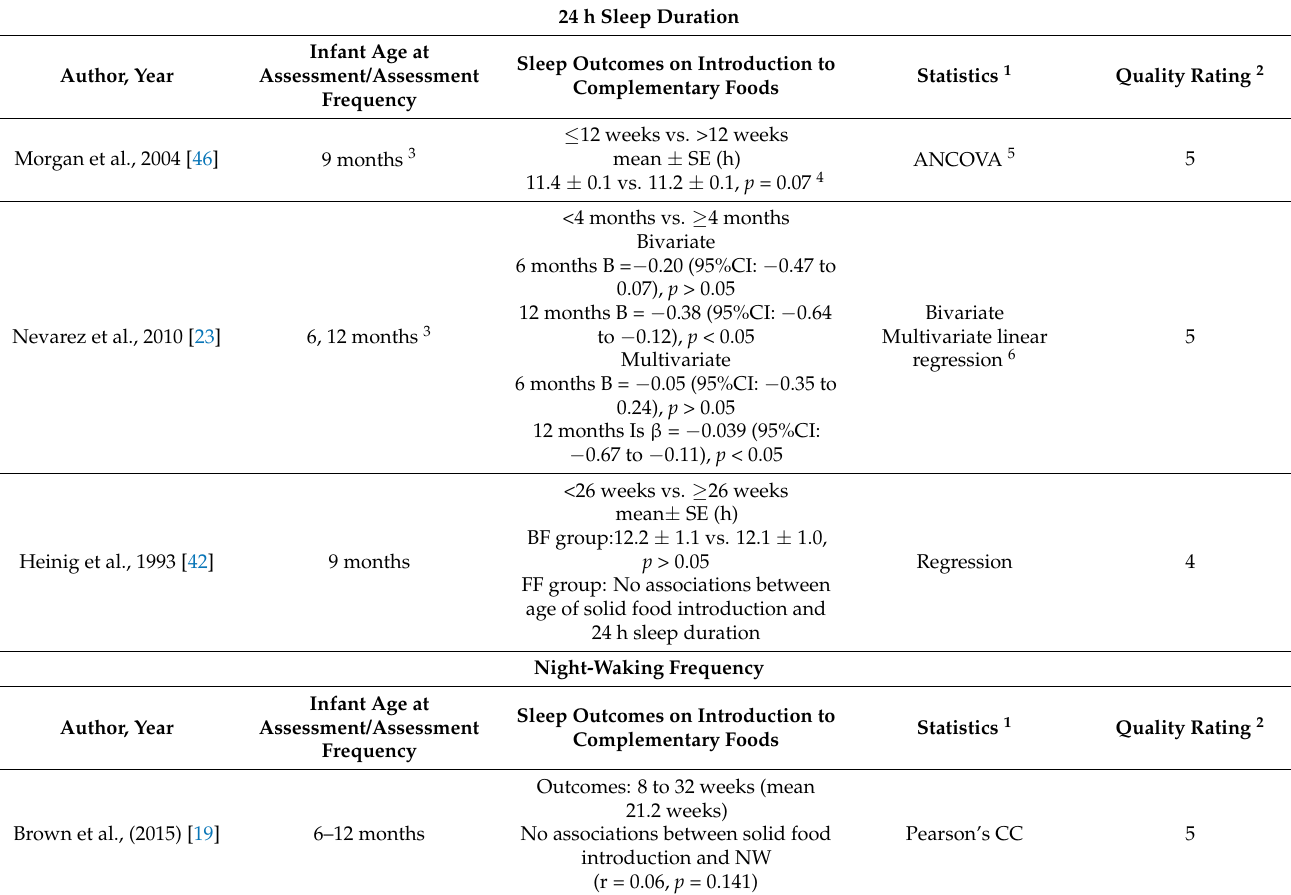
Table 3. Timing of introduction to complementary foods in relation to sleep variables including 24 h sleep duration and night-wakings frequency among infants 12 months-of-age and under.